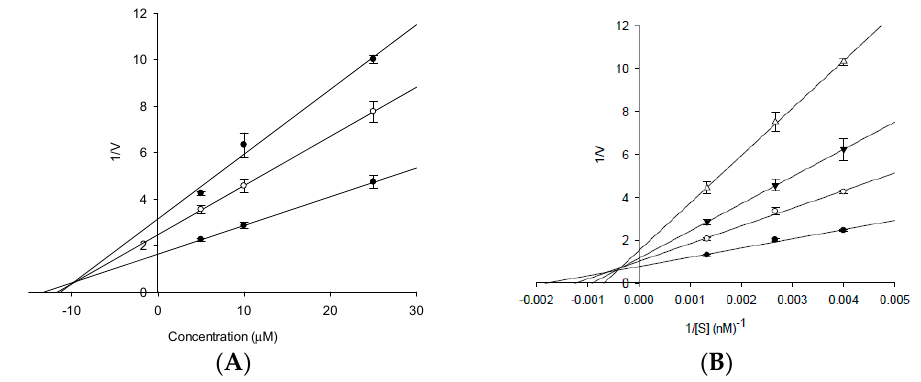
), (cid:35) ), 20 ( (cid:72) ), (cid:35)